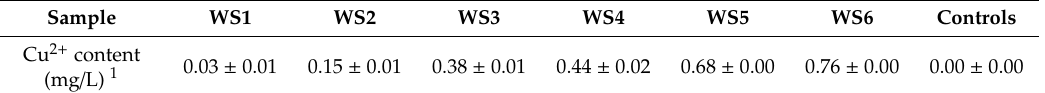
Table 1. Results of copper (II) ions present in white wine samples with di ff erent copper concentrations. Sample WS1 WS2